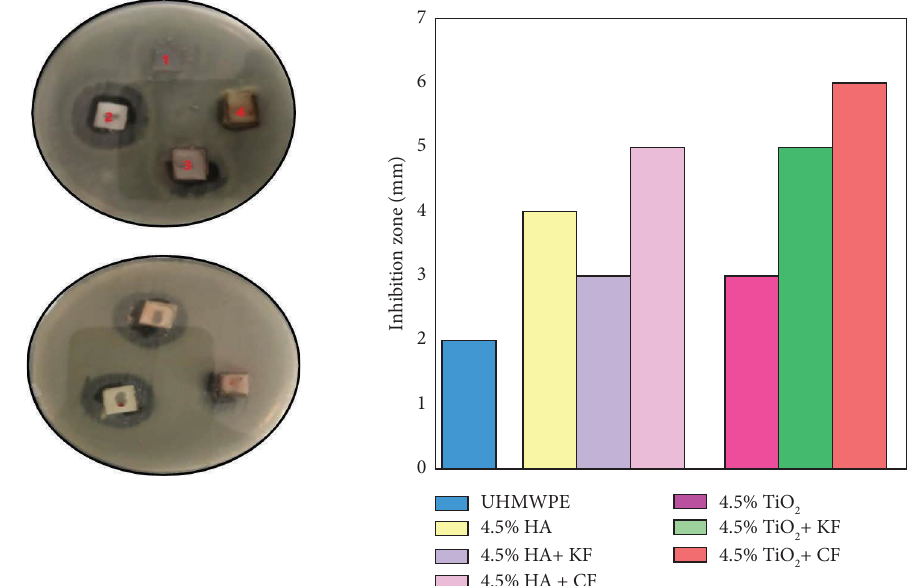
Figure 6: Inhibition zone of the n-HA and n-TiO 2 particulate and hybrid biocomposites against E. coli